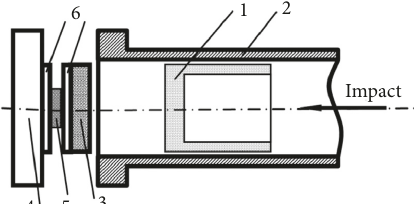
Figure 2: Schematic presentation of arrangement for the impact test. (1) Projectile; (2) air gun barrel; (3) Al foam specimen; (4) backing plate; (5) pressure gauge; (6) two rigid platens.